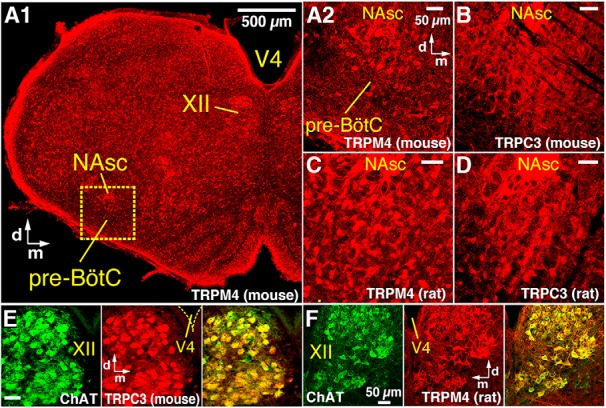
Immunolabeling of TRPM4 and TRPC3 channels in pre-BötC neurons and motoneurons. A, B, Confocal fluorescence microscopy images of coronal sections from neonatal mouse medulla at the level of the pre-BötC, showing widely distributed neuronal labeling by TRPM4 (A1, low magnification; A2, higher magnification of dashed box in A1) and TRPC3 (B) channel antibodies (red) within the pre-BötC region and motoneurons within the semicompact division of nucleus ambiguus (NAsc). Note extensive antibody labeling also outside of these regions (A1). C, D, Confocal images of the pre-BötC region from adult rats, showing neuronal labeling by TRPM4 (C) and TRPC3 (D) channel antibodies within the pre-BötC and labeling of NAsc motoneurons. E, F, Confocal images of the hypoglossal (XII) motor nucleus on one side of the medulla at the level containing the pre-BötC from neonatal rat (E) and mouse (F), showing TRPM4 (E) and TRPC3 (F) channel antibody labeling (red) of XII motoneurons identified by ChAT immunolabeling (green). Merged images (right in E and F) show antibody colabeling of XII motoneurons. A–D have the same dorso-medial anatomic orientation. d, dorsal; m, medial; V4, 4th ventricle.